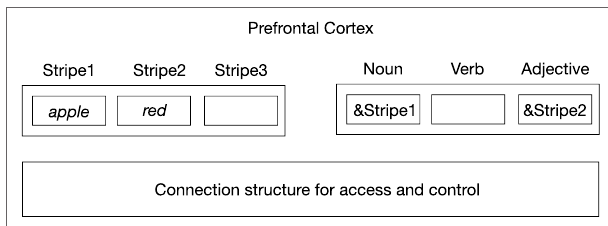
FigUre 2 | Indirection representation of red apple based on Kriete et al. (2013). Neural codes for concepts (e.g., apple , red ) are stored in memory locations (“stripes”) in the prefrontal cortex. The addresses of these stripes (as given by the address operator &) are then stored in “role stripes,” needed to establish the relation between the concepts. An underlying connection structure provides and controls access to